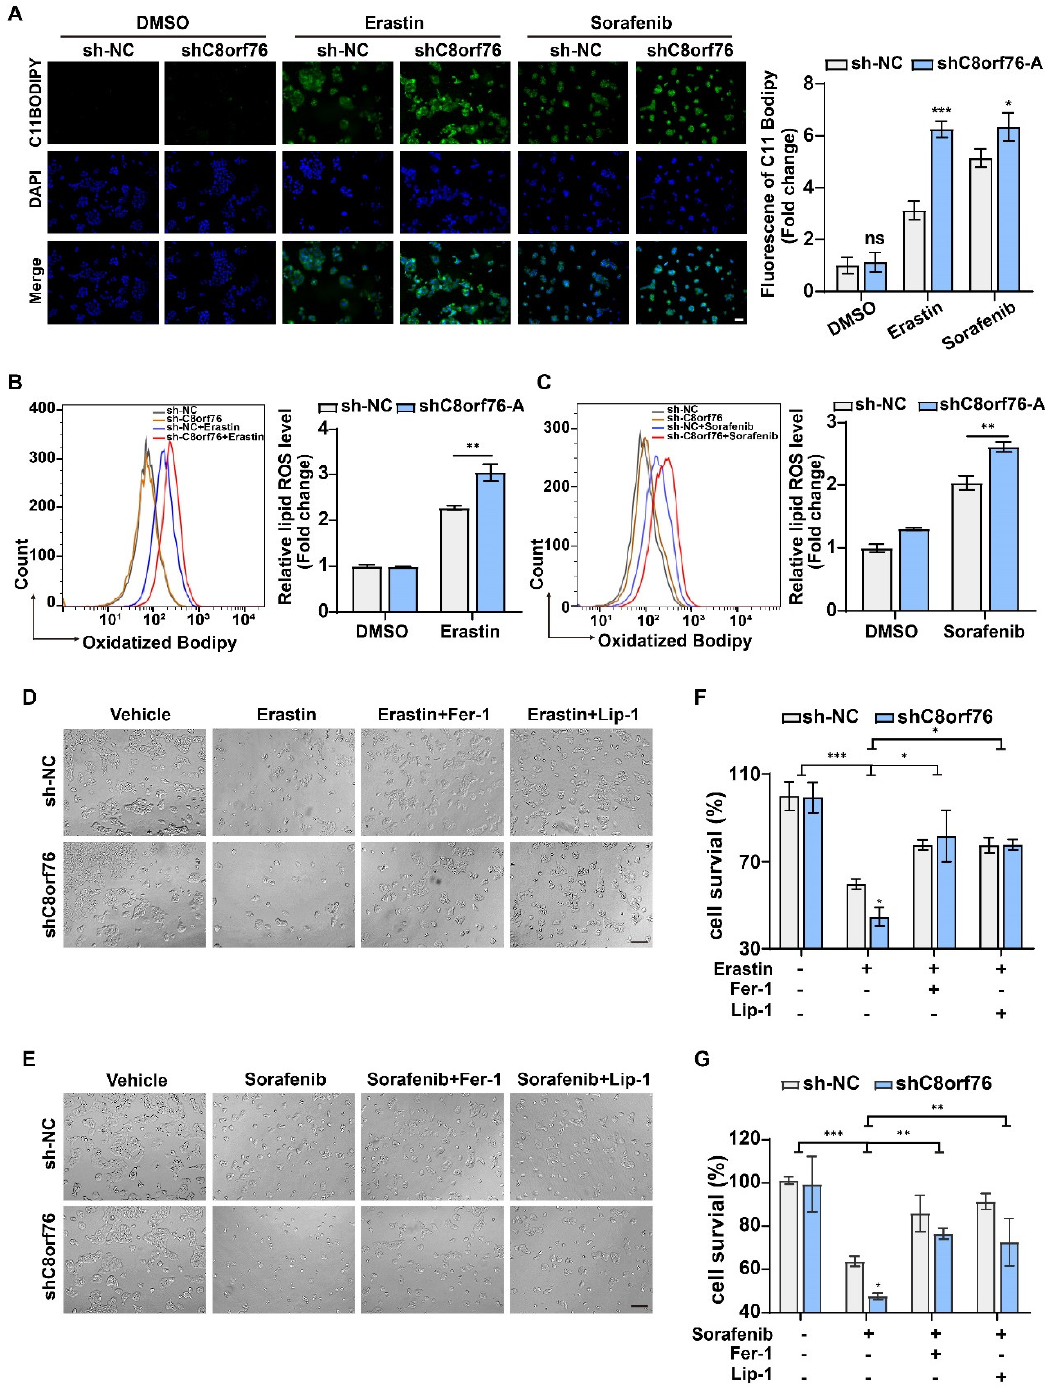
Figure 4. C8orf76 knockdown renders cells susceptible for ferroptosis and lipid ROS accumulation. ( A ) Representative images of C11−BODIPY staining in JHH7 cells after erastin and sorafenib treatment were photographed by an inverted fluorescent microscope. Scale bars represent 50 μm. ( B , C ) Flow cytometry was performed to assess the lipid ROS accumulation of JHH7 cells treated with erastin or sorafenib for 24 h using C11−BODIPY. ( D , E ) Representative images of HCC cells treated with erastin (7.5 μM) or sorafenib (5 μM) with or without Fer−1 (1 μM) or Lip−1 (0.4 μM) for 24 h. Scale bars represent 200 µ m. ( F , G ) The rescue effect of ferroptosis inhibitors on erastin or sorafenib treatment was explored through an MTS assay. Data were presented as mean ± SD. * p < 0.05; ** p < 0.01; *** p < 0.001; ns, not significant. Fer-1, ferrostatin-1; Lip-1,